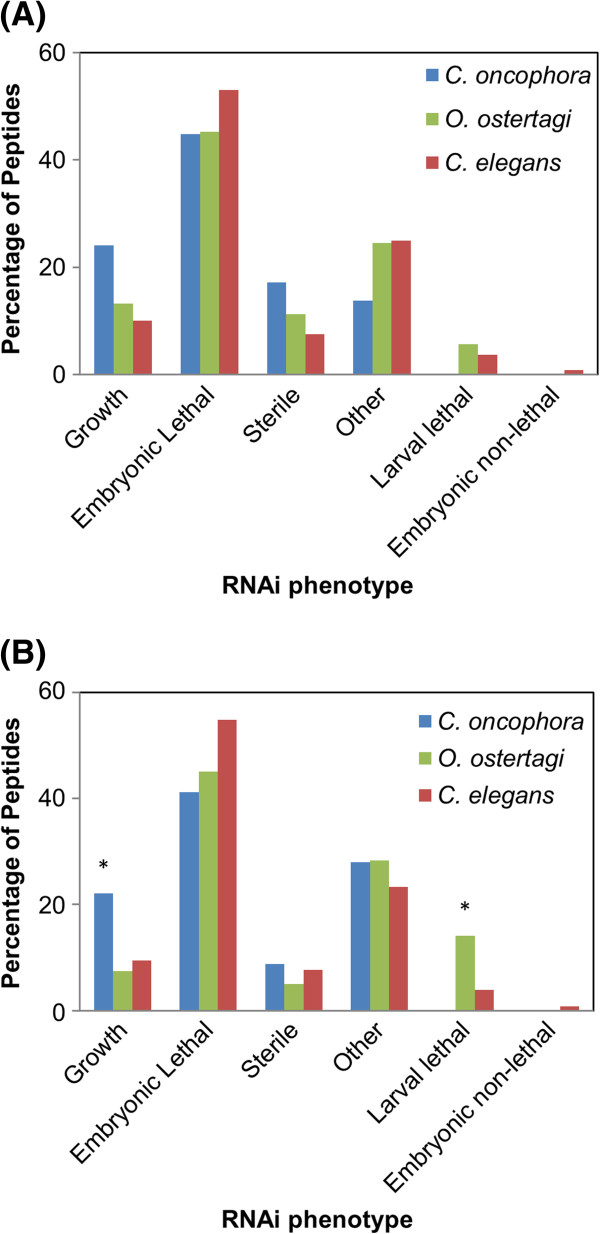
Comparison of phenotype distribution between RNAi-surveyed C. elegans genes, and C. onchophora and O. ostertagi homologues to C. elegans genes with similar phenotypes. (A). The percent of C. oncophora peptides encoded by transcripts expressed in free-living stages (egg, L1, L2 and L3sh) with homologs to C. elegans proteins with various RNAi phenotypes. (B). The percent of O. ostertagi peptides encoded by transcripts expressed in parasitic stages (L3ex, L4 and adult) with homologs to C. elegans proteins with various RNAi phenotypes. “*” indicates that for a specific RNAi phenotype, significantly more (p < 0.05) peptides in either C. oncophora or O. ostertagi exhibited that phenotype than did C. elegans.